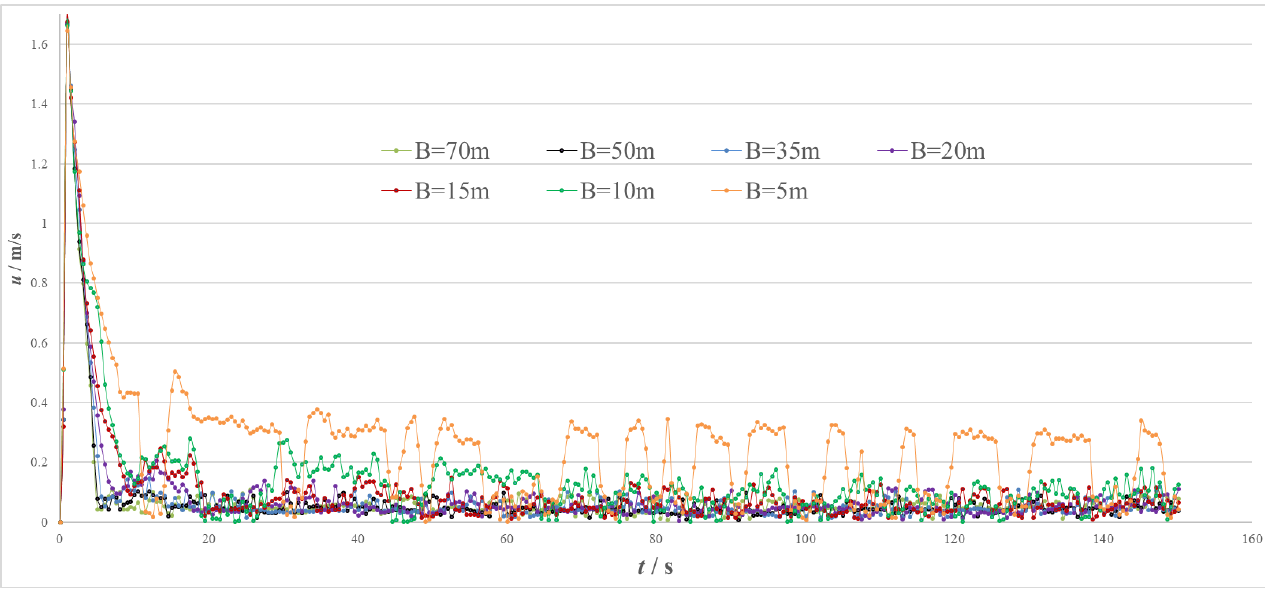
avalanche was terminated, a new balanced state was reached, which is represented by the plateaus in Figures